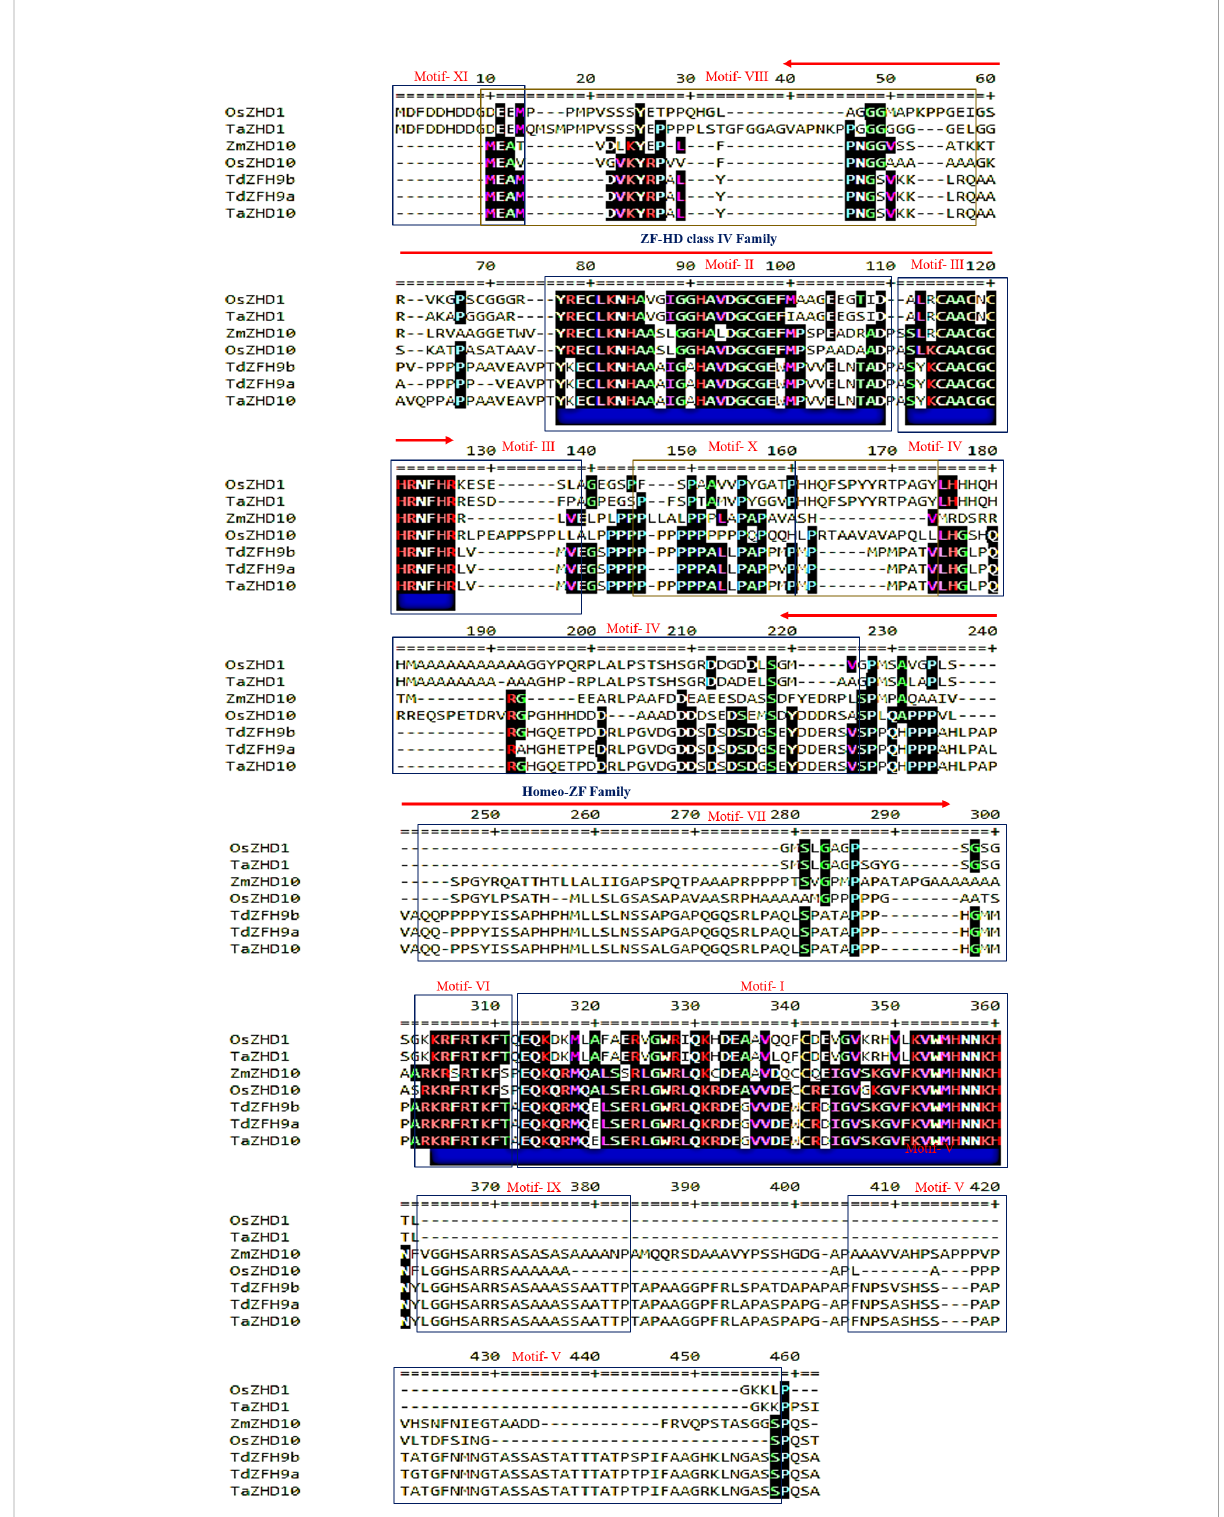
FIGURE 5 Multiple sequence alignment of the conserved domain and motifs distributed across the candidate leaf rolling ZHD genes in wheat and its